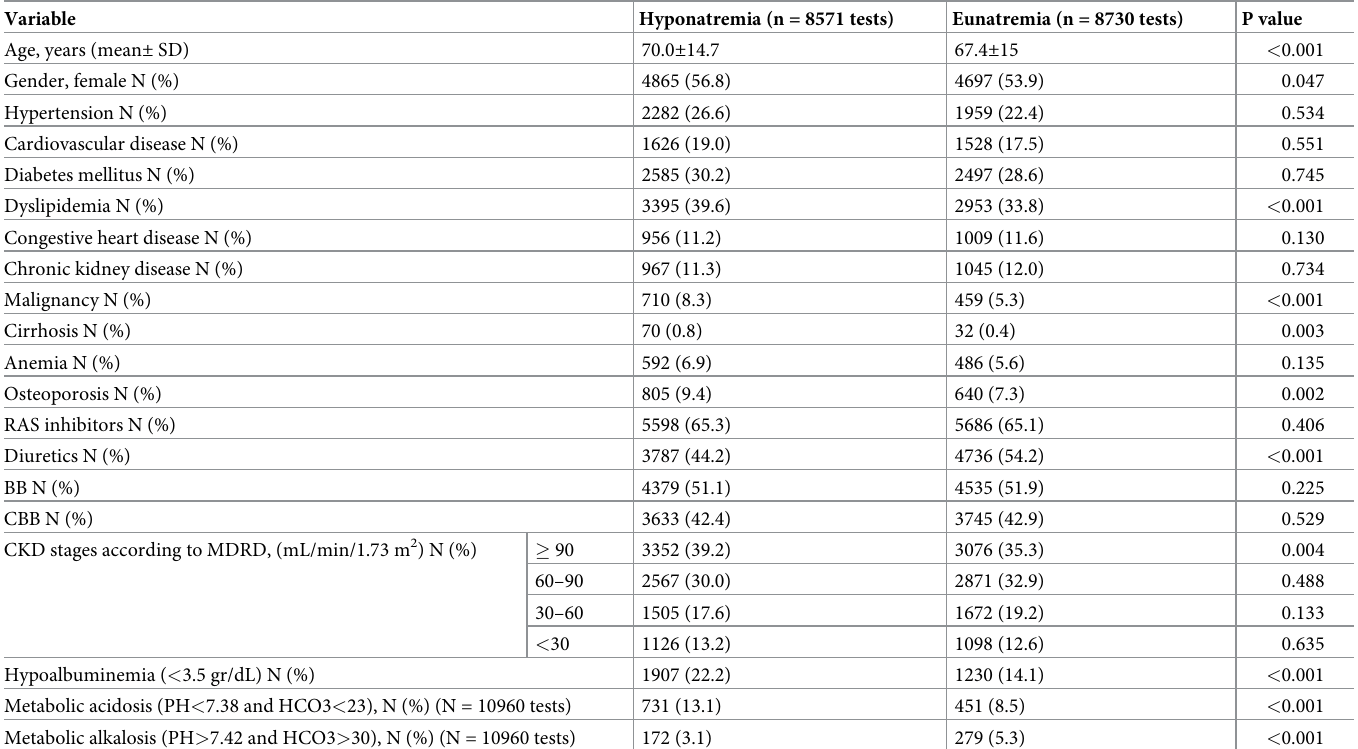
Table 2. Sub-population of hypochloremia ( < = 97 mmol/L), per natremia status (n = 17301 tests, adjusted to same patients